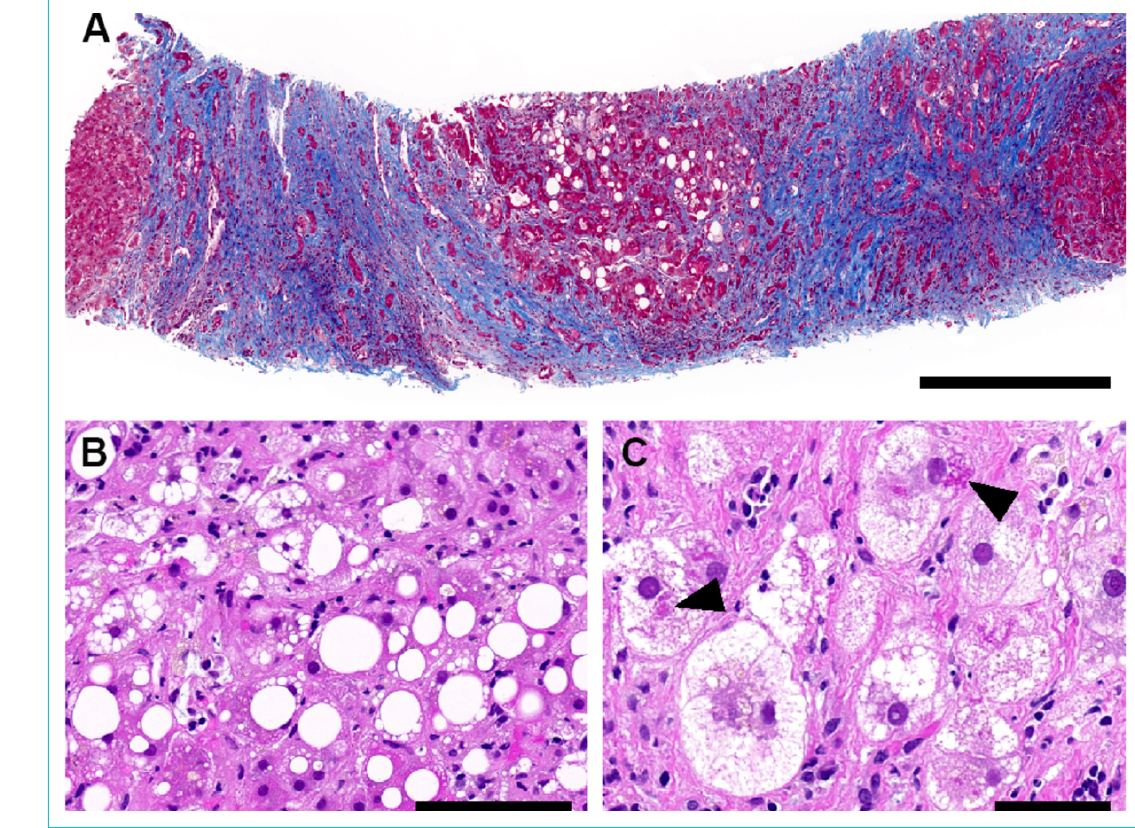
Figure 1: Histopathological findings in liver biopsies, exemplified by patient 3. (A) Cirrhotic liver parenchyma with steatosis (Masson trichrome stain; scale bar: 500 μm). (B) Macro- and microvesicular steatosis with necroinflammation (H and E stain; scale bar: 100 μm). (C) Hepatocytes with ballooning and Mallory-Denk hyaline (black arrowheads) (H and E stain; scale bar: 50